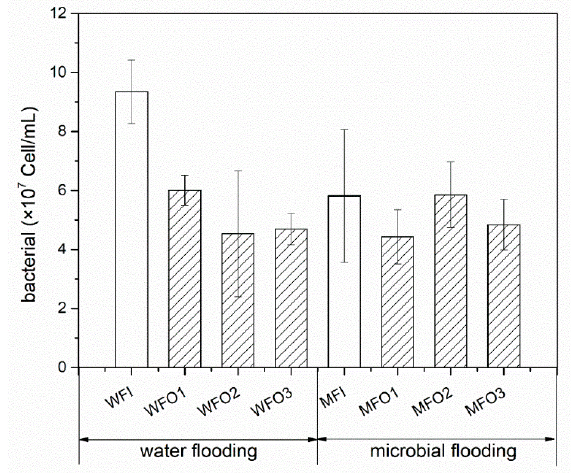
Figure 3. Bacterial abundances in production fluids from the Daqing oilfield. The bars with slash represent production wells, and bars without slash represent the injection